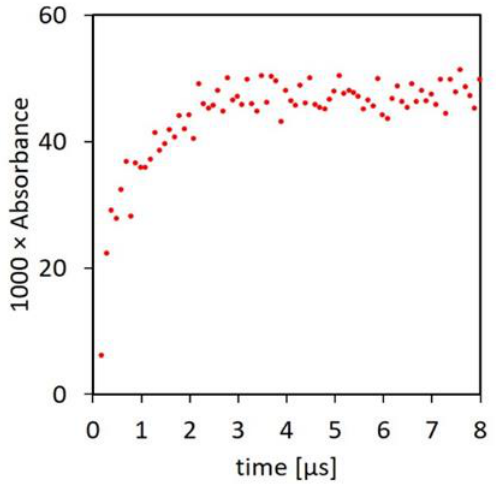
Figure 3. Formation of the adduct radical at 375 nm by pulse radiolysis. The irradiated solution contained 50 μM morin, 10 mM N -Ac-Ala-NH 2 , and 20 mM phosphate buffer at pH 7, and it was saturated with N 2 O [73].